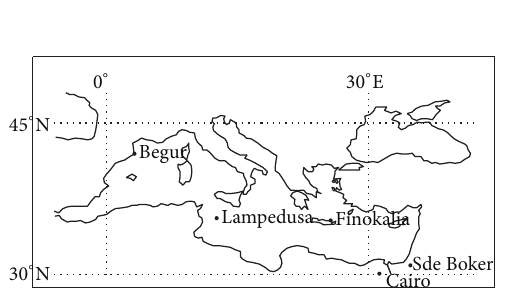
Figure 11: Map of the GAW